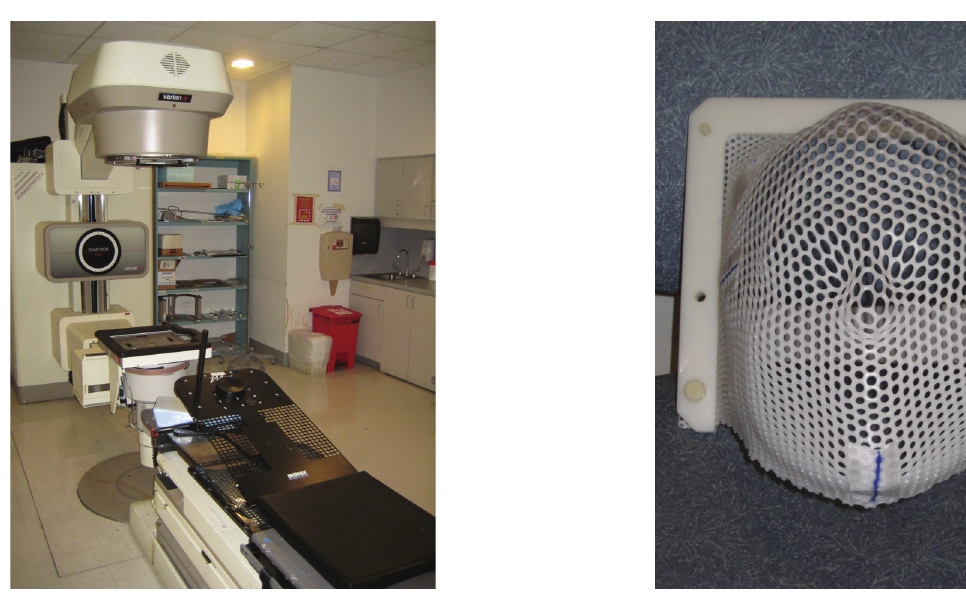
Figure 2: The simulation machine. Figure 3: A premolded aquaplast.